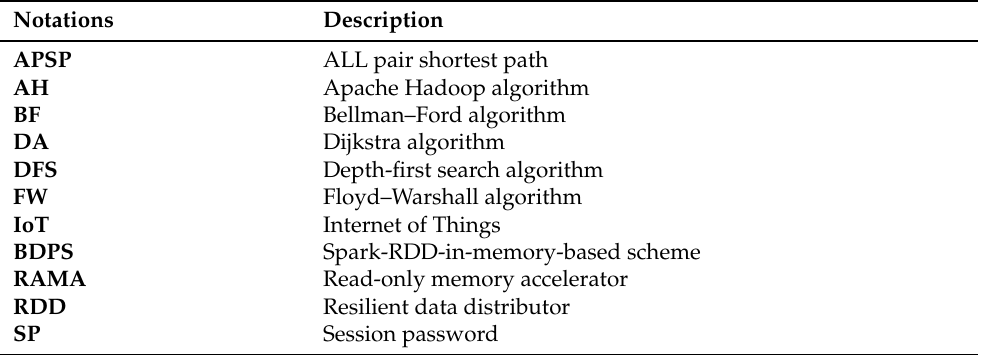
Table 1. List of acronyms used in alphabetical